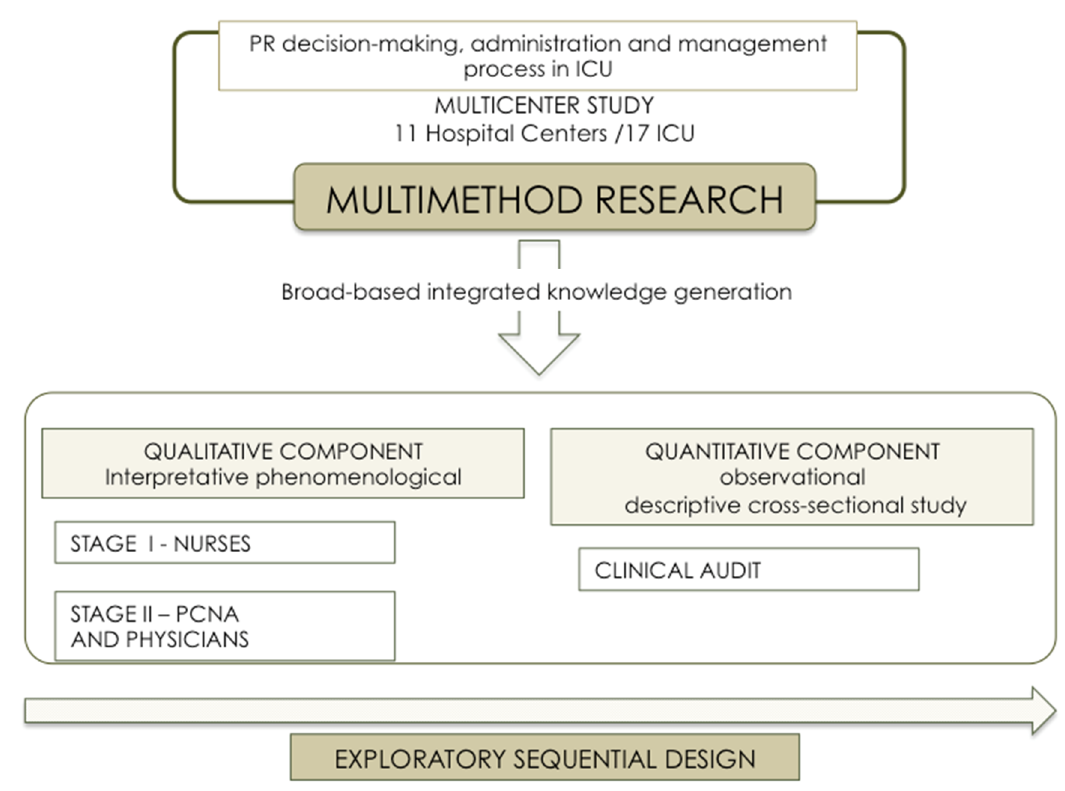
Figure 2. General scheme of the multimethod design. Abbreviations: PCNA: patient care nursing assistants; PR: physical restraint; ICU: intensive/critical care units.